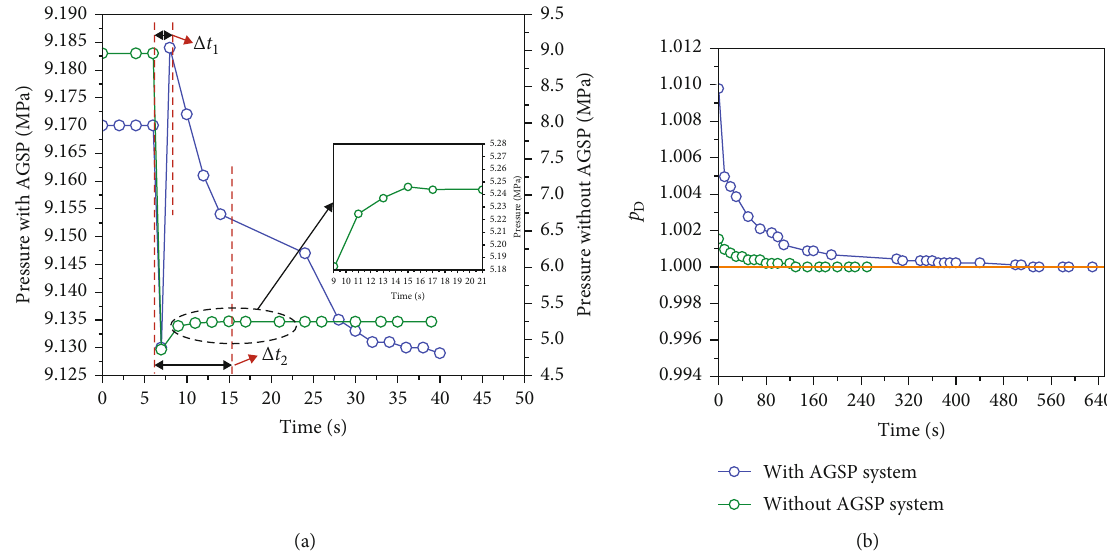
Figure 6: The (a) initial stage and the (b) whole process of pressure drops with and without AGSP system at 303.15K, with Sample 3.